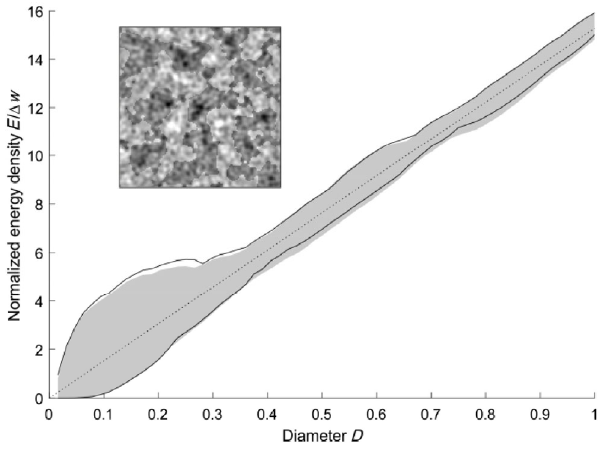
Fig. 14 Transition between bi-modal and uni-modal energy density may be the mechanism of transition to catastrophic